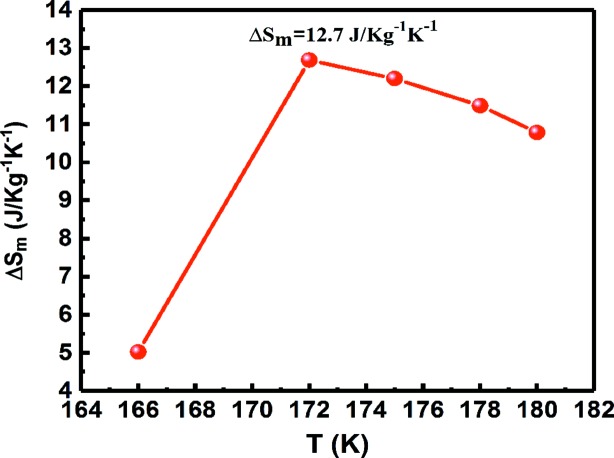
The temperature dependence of the reversible magnetic field-induced entropy change ΔS
m for a field change from 0.1 to 5 T for the Ni43.7Cu1.5Co5.1Mn36.7In13 microwire.